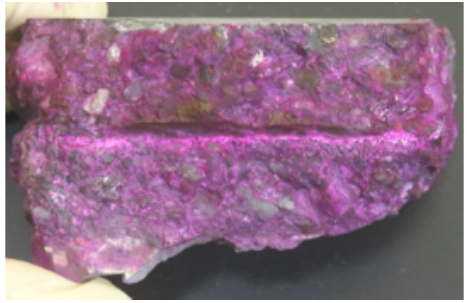
Figure 18. Observation results of steel mark in con- crete test piece after neutralization